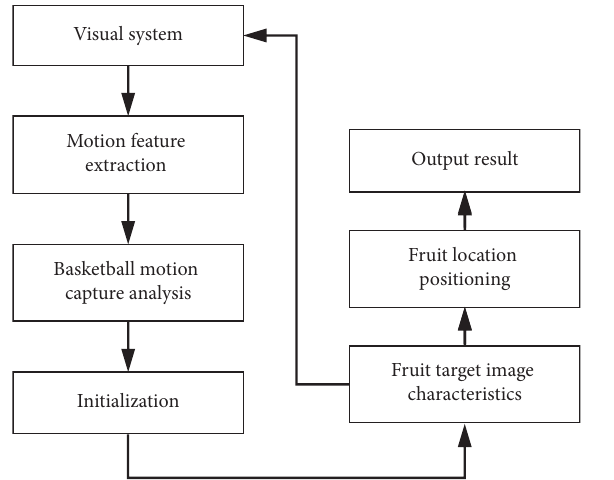
Figure 2: Basketball motion capture flowchart.